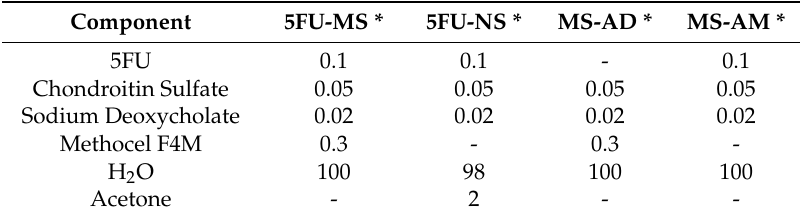
Table 3. Constitution of the formulations.